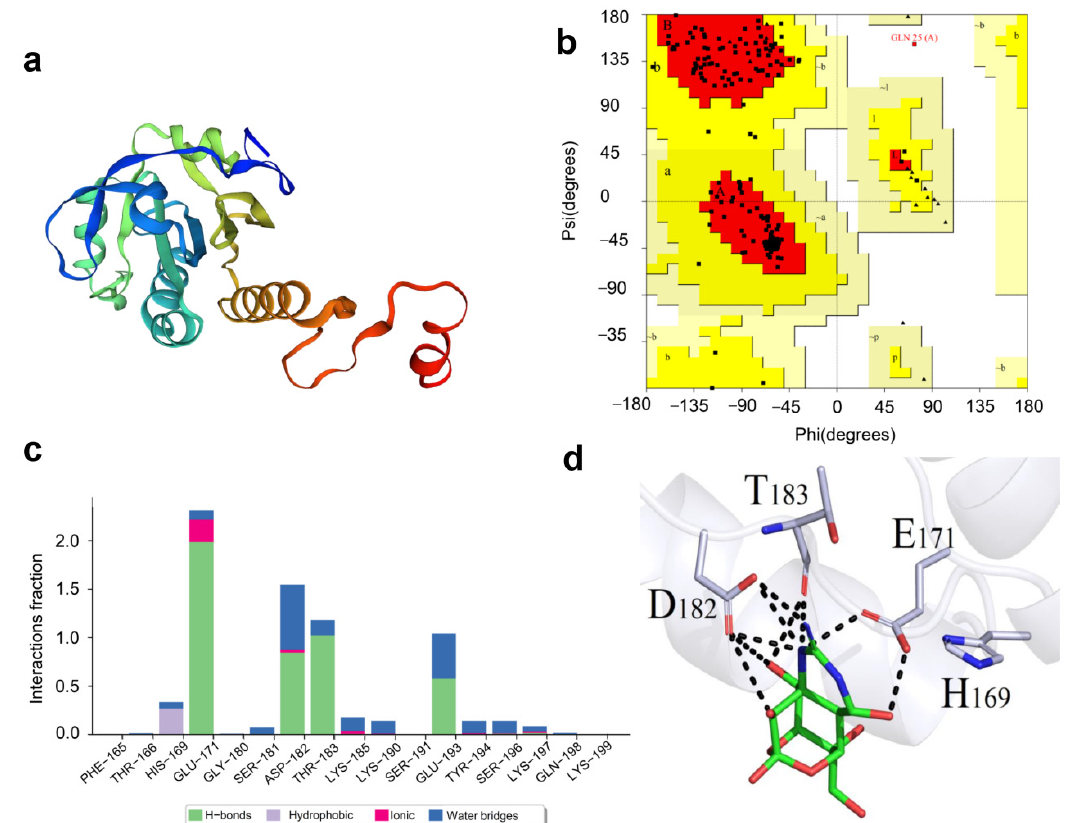
Figure 7. Protein modeling of Tbprx-1 and molecular docking of Tbprx-1 and tetrodotoxin (TTX). ( a ) Diagram of the homology modeling structure of Tbprx-1. ( b ) Ramachandran plot of Tbprx-1. ( c ) Interaction fractions of individual amino acid residue in Tbprx-1. ( d ) Binding model depicted in 3D, with green denoting the ligand and gray rods denoting amino acid residues around the binding pocket. The backbone of the receptor is indicated by a light gray ribbon. The black dashed line indicates the hydrogen bond between the ligand and the receptor.